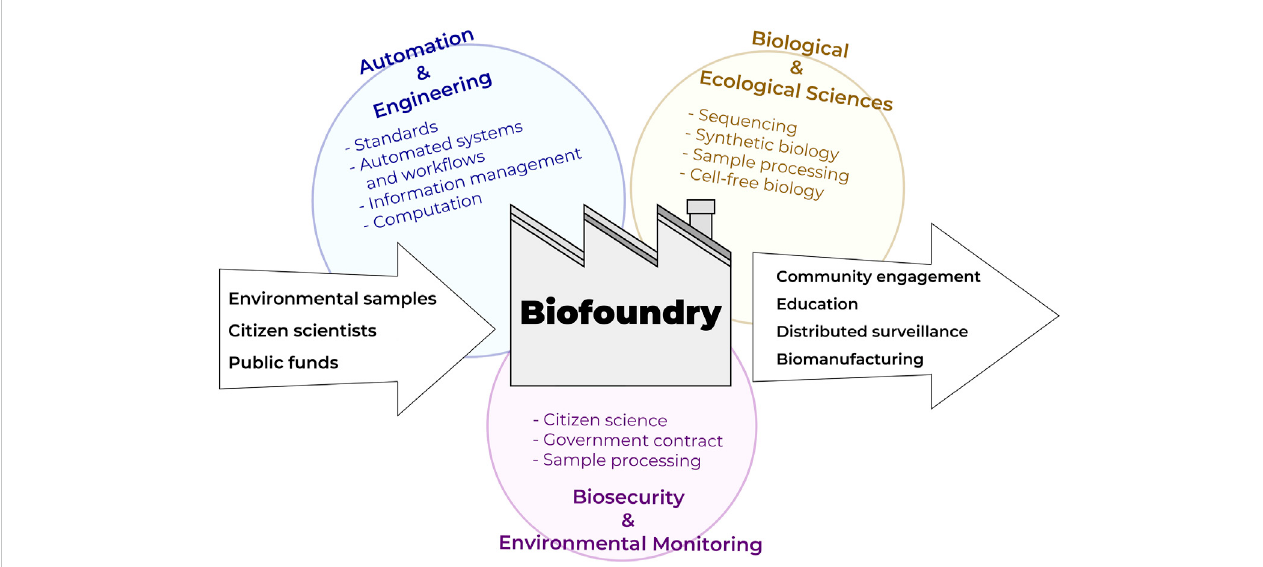
FIGURE 3 Biofoundries at the nexus of automation technologies, bioengineering, and biological/ecological monitoring interfacing with citizen science